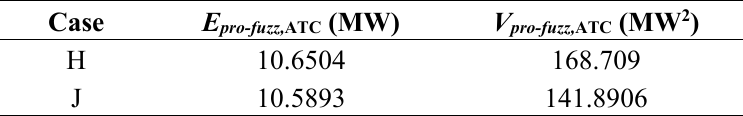
Table 9. The results of Case H and Case J.